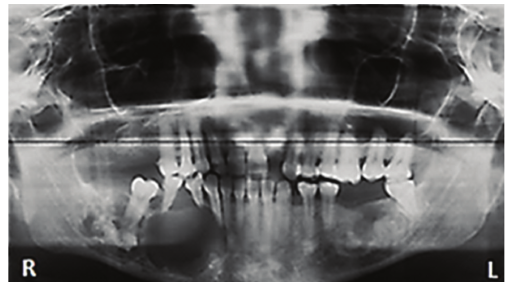
Figure 4: An orthopantomogram of the patient in case 2 showing a significant bone destruction of the right mandible extending from the lower right lateral incisor to a region just short of the mandibular angle. The radiolucency also encompasses the irregular mass of radio-opacity just apical to right mandibular first molar. The radiograph shows a similar irregularly shaped radio-opacity within the body of the left